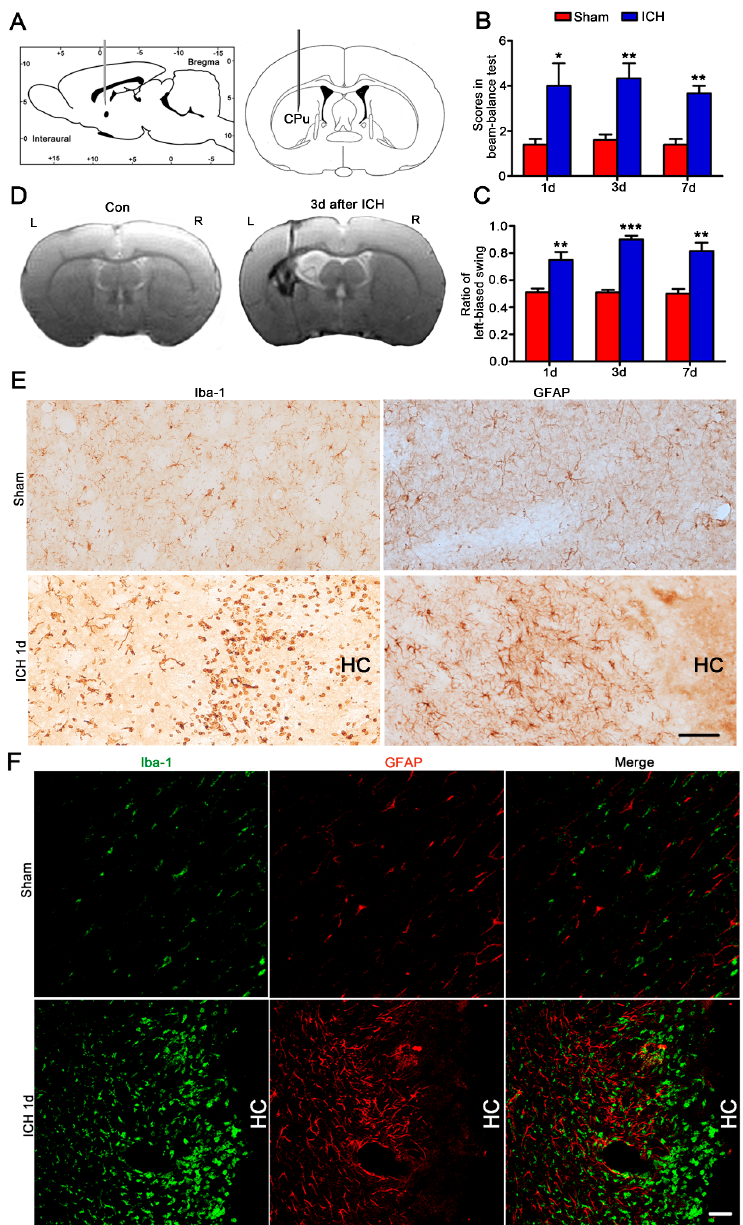
Figure 1. Increased and accumulated microglia/macrophages and astrocytes in the hemorrhagic caudate putamen (CPu) of rats. 0.4 U of collagenase VII (2 μ L) was injected into the left CPu of three-month-old male Sprague–Dawley (SD) rats ( A , ICH). Sham rats (Sham) received 2 μ L 0.9% NaCl injection. Beam balance test ( B , n = 5/group), elevated body swing test ( C , n = 5/group), and brain magnetic resonance imaging (MRI) test ( D , n = 4/group) were performed to evaluate the model. By immunohistochemistry staining on brain slices (20 μ m), Iba-1 (marker of microglia/macrophage) positive cells and GFAP (marker of astrocyte) positive cells were shown in the collagenase VII injected CPu ( E , Bar = 50 μ m). By double-label immunofluorescence staining, microglia / macrophages (green) were found much closer to the hemorrhagic center (HC) than astrocytes (red) ( F , Bar = 50 μ m). The data were expressed as means ± standard error of the mean (SEM).* p < 0.05, ** p < 0.01, *** p < 0.001, vs. Sham.